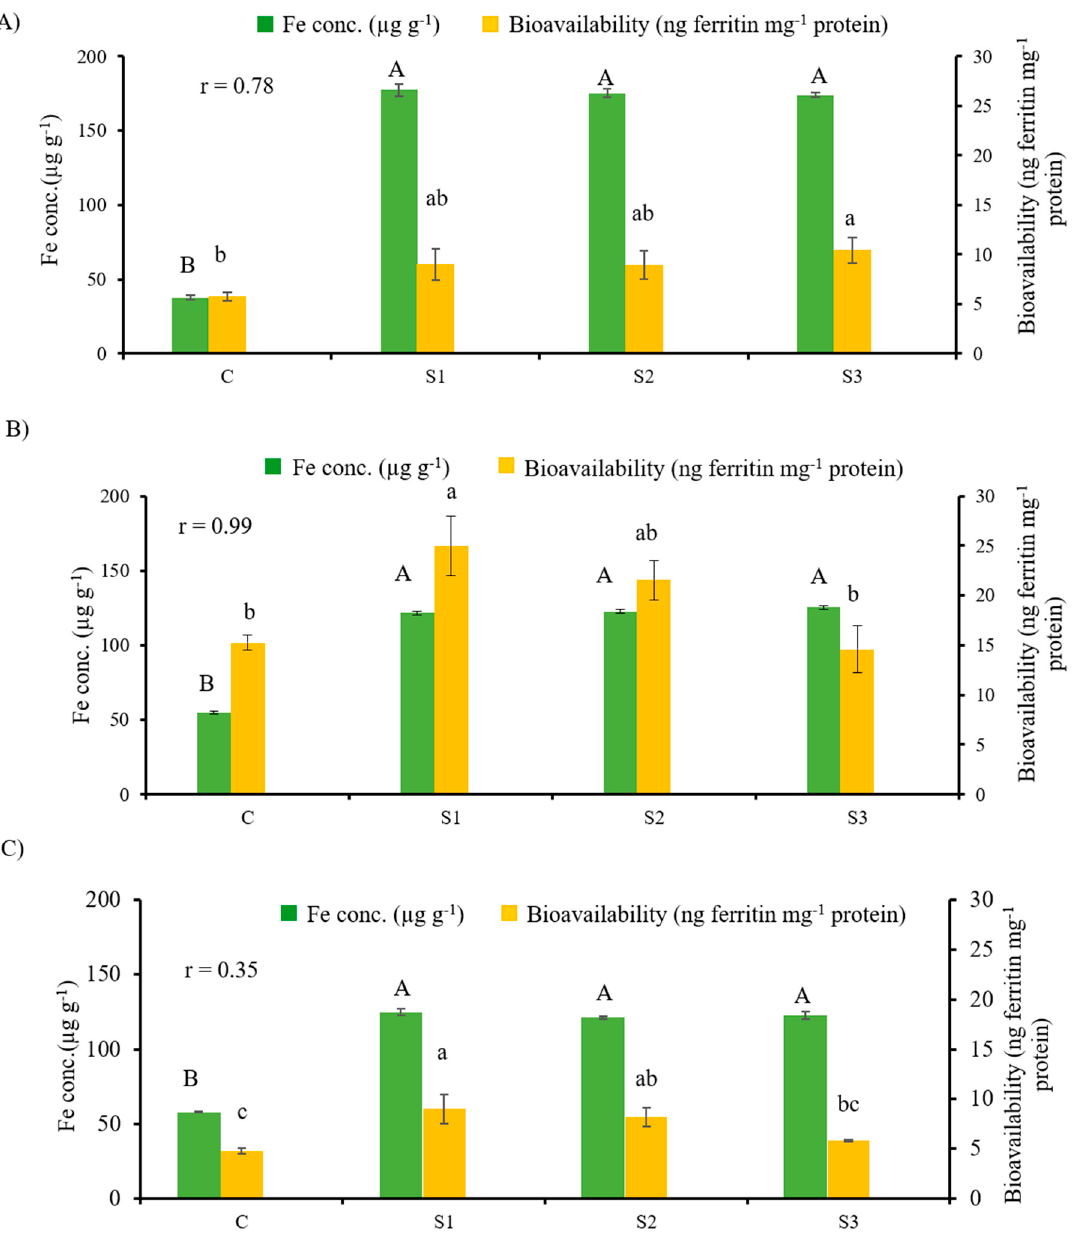
Figure 1. Iron concentration ( µ g g − 1 ) and bioavailability (ng ferritin mg − 1 protein) of ( A ) cooked split desi seeds (soup) ( n = 4; C = soup control, S1 = soup fortified with FeSO 4 · 7H 2 O, S2 = soup fortified with FeSO 4 · H 2 O, and S3 = soup fortified with NaFeEDTA); ( B ) chapatti prepared from desi flour ( n = 4, C = desi chapatti control, S1 = desi chapatti fortified with FeSO 4 · 7H 2 O, S2 = desi chapatti fortified with FeSO 4 · H 2 O, and S3 = desi chapatti fortified with NaFeEDTA); and ( C ) chapatti prepared from kabuli flour ( n = 4, C = kabuli chapatti control, S1 = kabuli chapatti fortified with FeSO 4 · 7H 2 O, S2 = kabuli chapatti fortified with FeSO 4 · H 2 O, and S3 = kabuli chapatti fortified with NaFeEDTA). Iron bioavailability was analyzed using the in vitro Caco-2 cell model. Upper case and lower case letters represent the mean comparisons of Fe concentrations and Fe bioavailability, respectively, across all the treatments. Bars (mean ± SEM) with the same letters are not significantly di ff erent ( p > 0.05) among the fortificants for that variable.